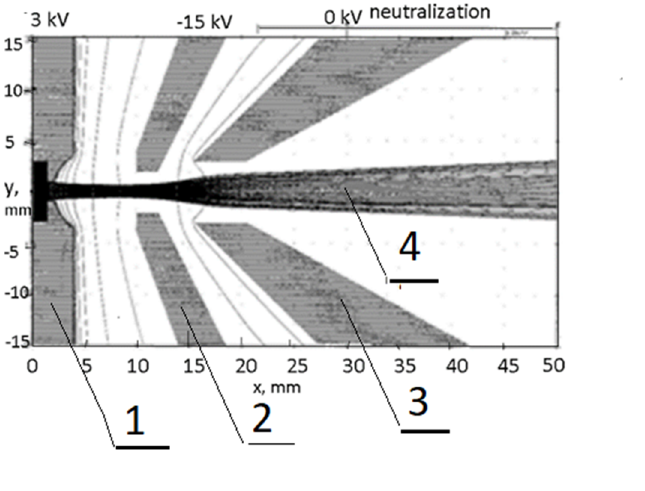
Figure 1. ( a ) Schematic of small anode ion source with power supplies, and ( b ) isometric view. 1 and 4—cathodes, 2—anode body, 3—emission slit, 5—cathode shields, 6—cathode insulators, 7— small anode, 8—small anode insulators, 9—small anode shields, 10 and 11—cathode power sup- plies, 12—gas discharge power supply, 13—small anode bias power supply.